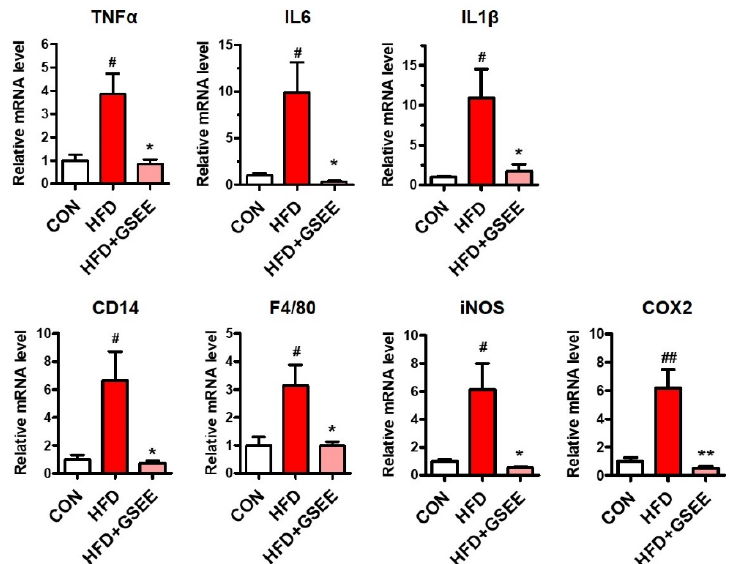
Figure 8. Suppressive effects of GSEE on the expression of inflammatory genes in HFD-fed mouse livers. Mice were fed with HFD for 10 weeks with or without daily oral administration of GSEE (45 mg/kg of body weight). Liver samples from randomly selected 4 mice in each group were used for qRT-PCR. The values are expressed as mean ± SE. Student’s t -test, #, ## p < 0.05 and 0.01, respectively, vs. control. *, ** p < 0.05, and 0.01, respectively, vs. HFD.